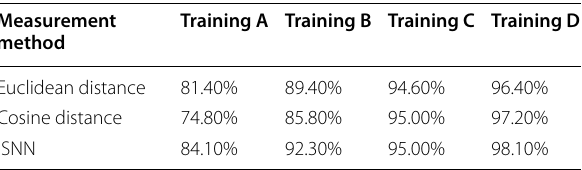
Table 4 Accuracy of different relationship measurement methods Measurement